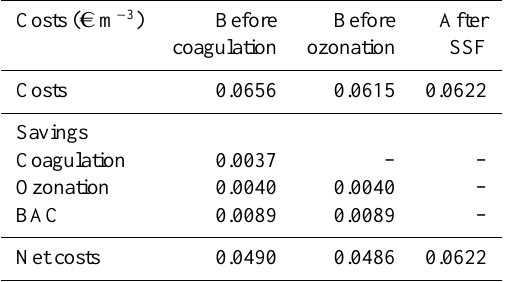
Table 6. Expected savings of downstream processes because of IEX and the calculated net